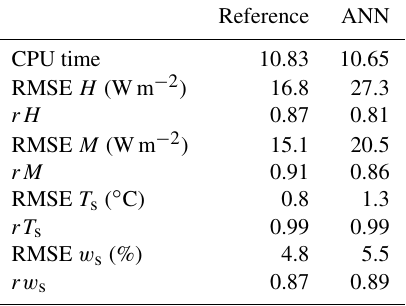
Table 8. Comparison of the reference version with the ANN version of Veg3d for the DE-Fal grassland station. H denotes the heat flux, M is moisture flux, T s is soil temperature and w s is soil moisture.